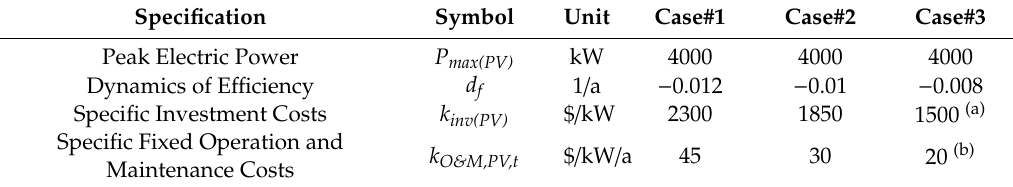
Table 4. Data for power generation technology—photovoltaic system. Note: Data sources: (a) [46], (b) [47].